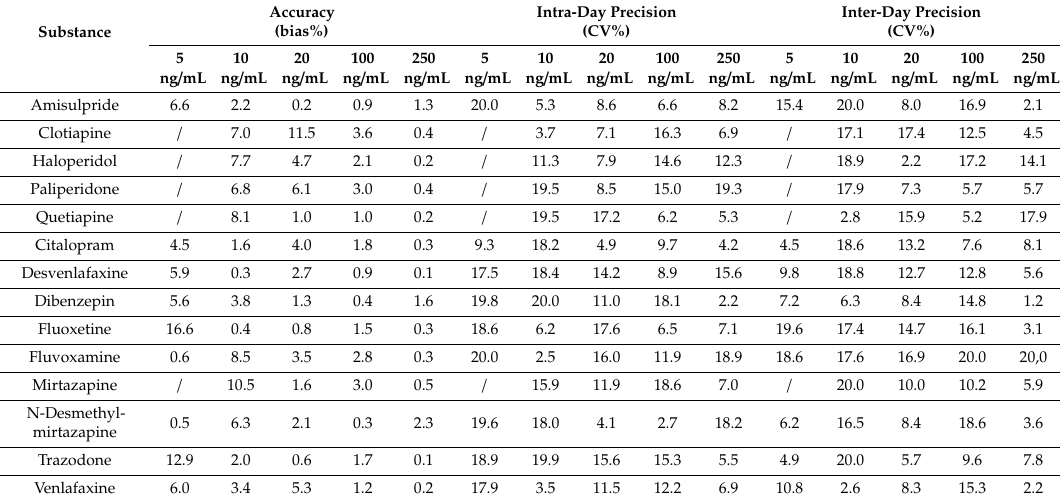
Table 2. Accuracy and precisions (5 replicates for each measurement). CV%: coe ffi cient of variation. Substance